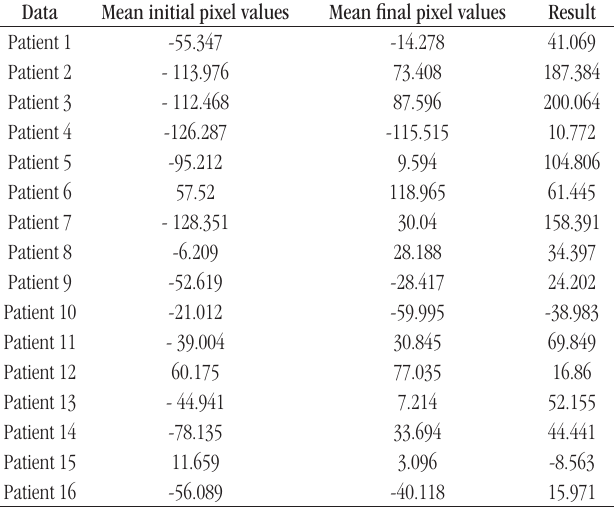
taBLE 2 − Mean initial and final pixel values, by patient